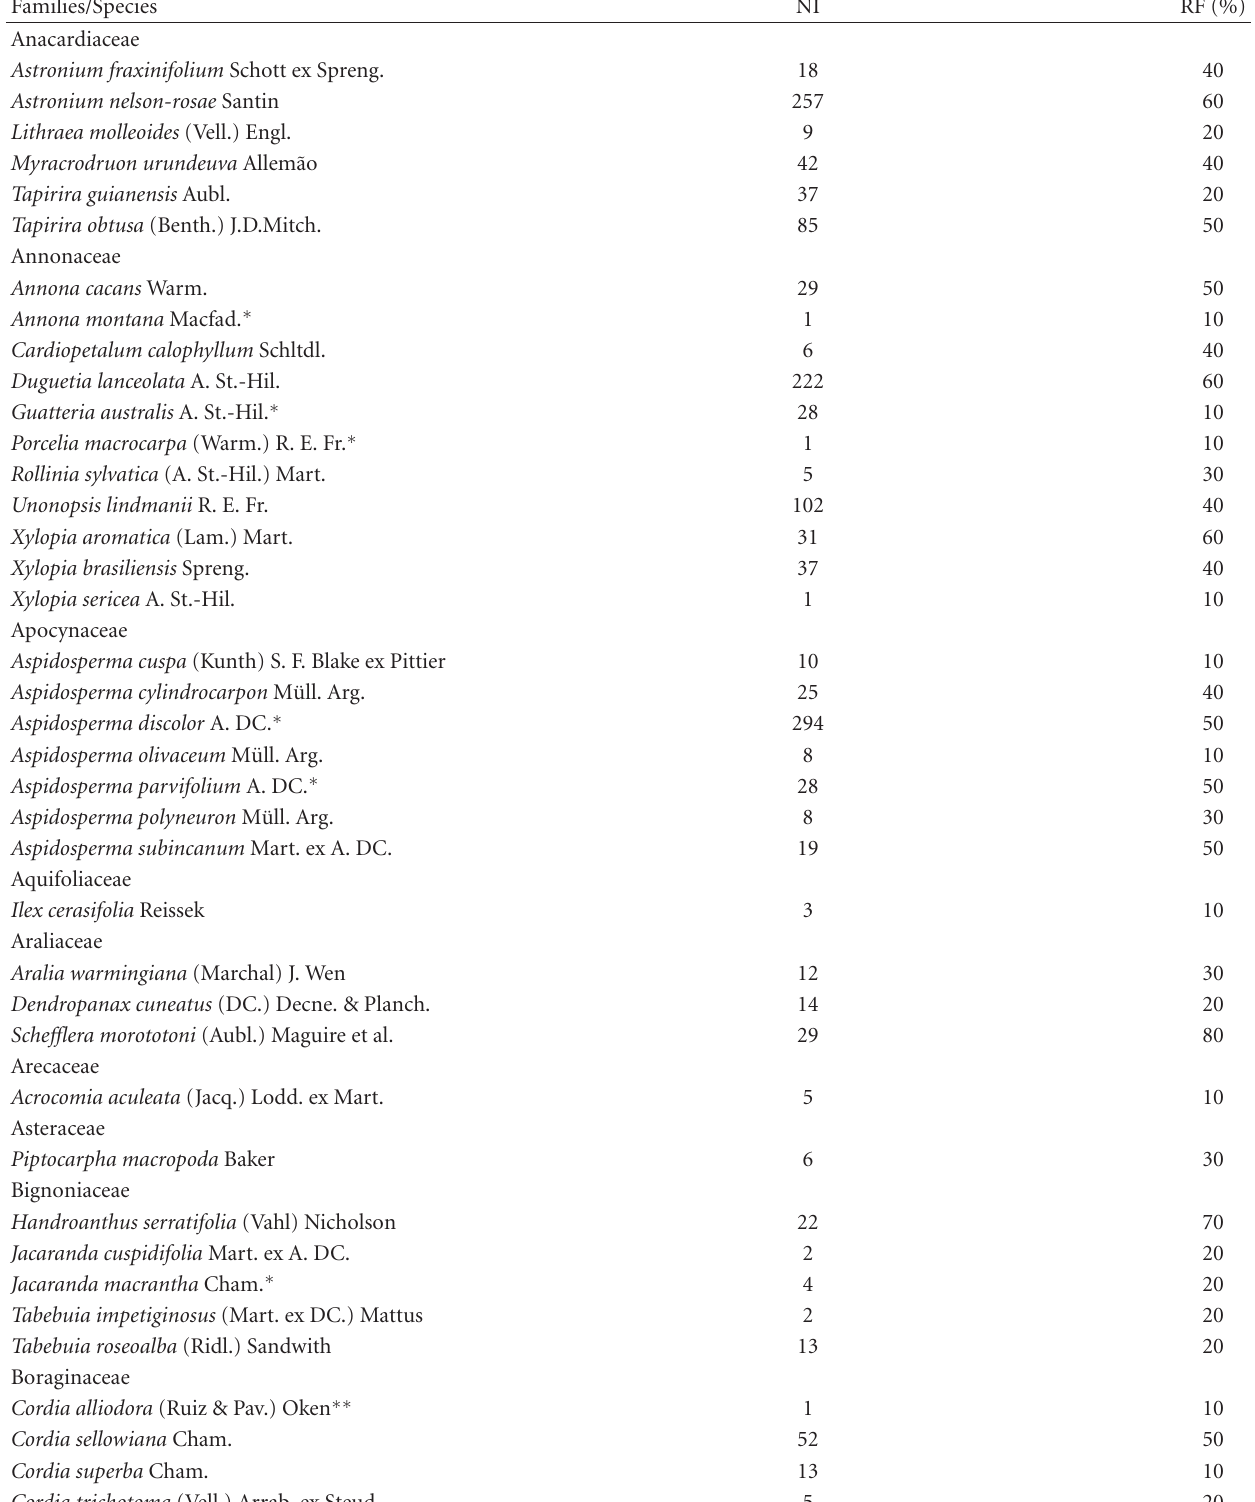
Table 3: Species list sampled in ten sites of seasonal semideciduous forest of southeastern Brazil. NI = number of individuals; RF = frequency in the ten studied fragments; ∗ First record for the Triangulo Mineiro region, ∗∗ First record for the Minas Gerais state in seasonal semideciduous forests, according